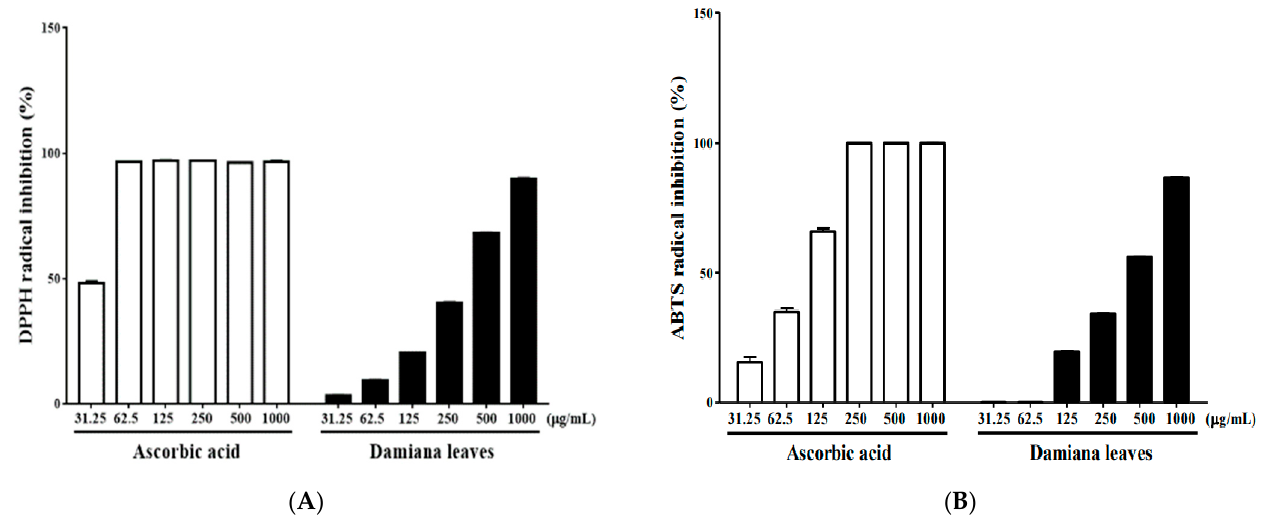
Figure 2. DPPH ( A ) and ABTS ( B ) inhibition of Damiana leaves extract. The results were shown as the mean ± SD of three independent experiments.